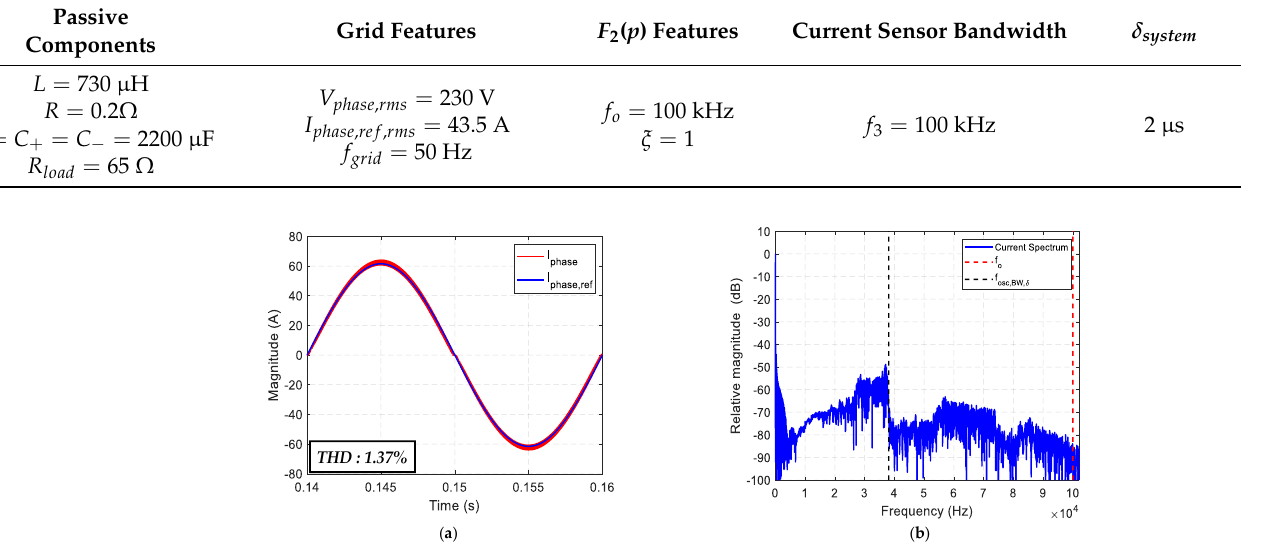
( b ) Figure 10. ( a ) Input current controlled by analog PSSOCC and ( b ) its related current spectrum. The current controlled by DSPSSOCC follows its reference with a very low THD of 1.37%. The spectrum analysis confirms this value with a strong reduction of low fre- quencies harmonics. Moreover the upper edge of the first intermodulation lobe is steep and allows a good interpretation of the maximum switching frequency value. Considering both figures, a high similarity is observed. It indicates the good per- formances retention of the discretized PSSOCC. The gap between the natural frequency of the second order filter and the maximum oscillation frequency from the theoretical approach increases with increasing 𝑓 𝑜 value. Then the model of the DPSSOCC devel- oped in this work is validated since it allows a perfect determination of the maximum oscillation frequency with excellent performance in regulation. 3.5. Controller Operating Limits